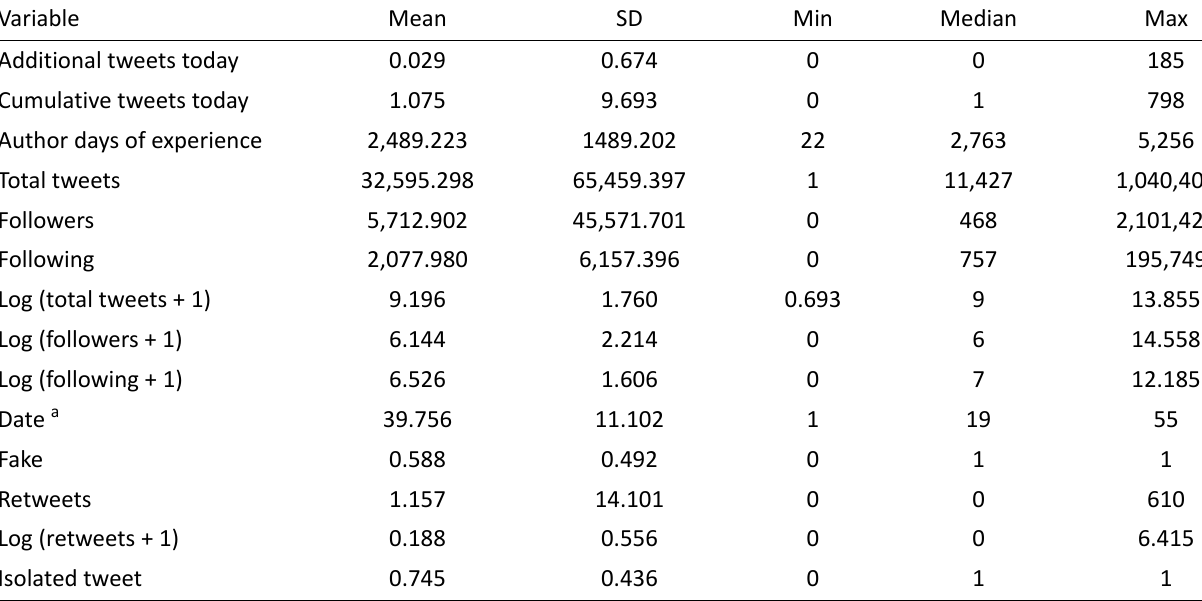
Table 5. Summary statistics (N = 235,088 days across tweets or tweet‐days ).